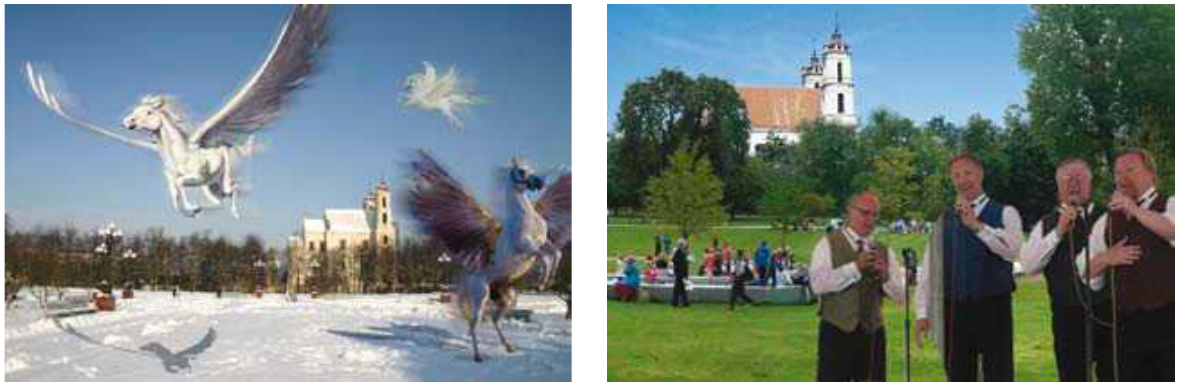
Fig. 12. Examples of Internet Poll